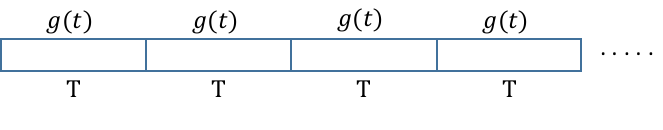
Figure 15. Periodic signal in emission.